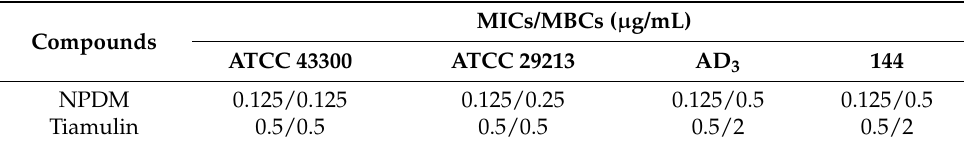
Table 1. MIC values and MBC values ( µ g/mL) for NPDM and tiamulin against MRSA ATCC 43300, S. aureus ATCC 29213, and two clinical strains of S. aureus (AD3 and 144). MICs/MBCs ( µ g/mL) Compounds ATCC 43300 ATCC 29213 AD 3 144 NPDM 0.125/0.125 Tiamulin 0.5/0.5